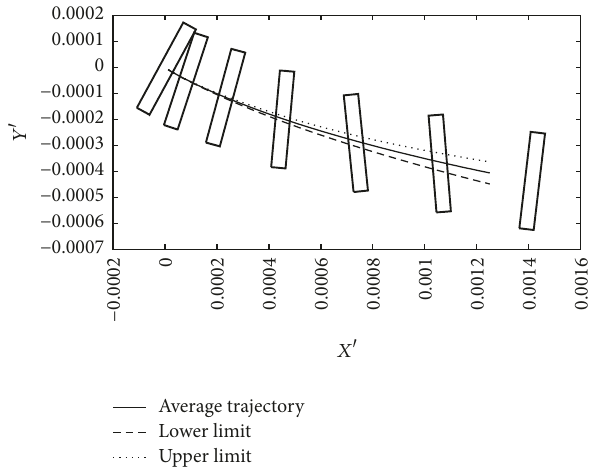
Figure 12: Mean trajectory and plate orientation for run (1) for a plate with an initial negative angle of attack.